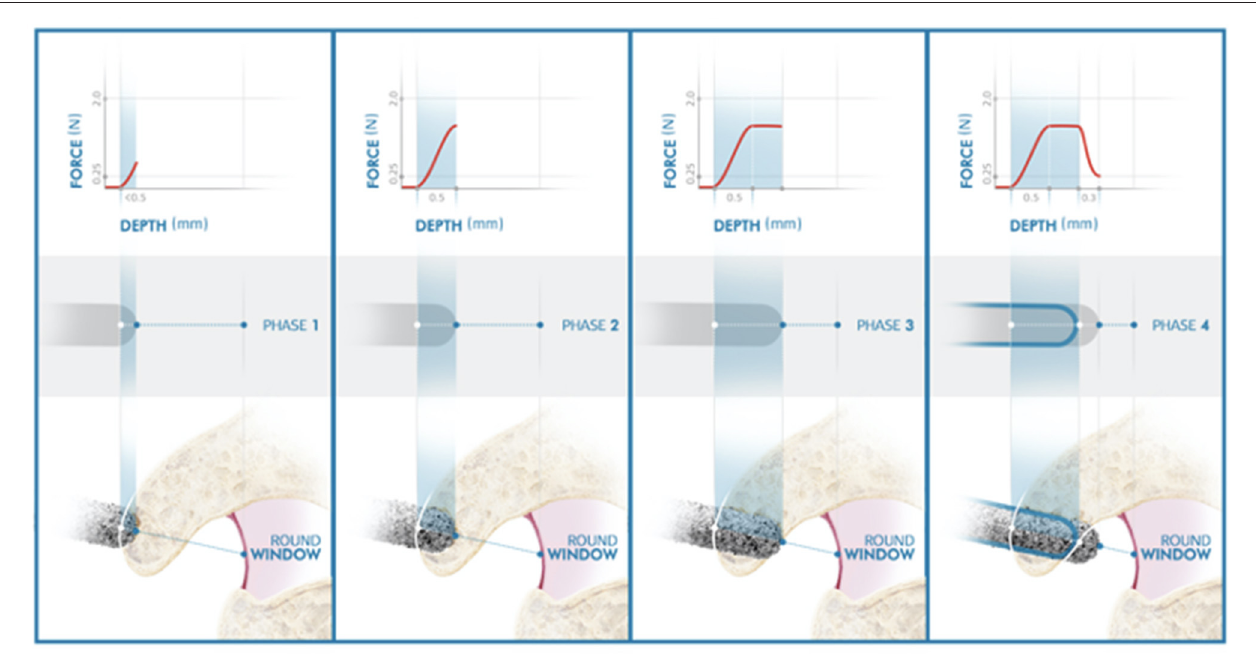
FIGURE 4 | Illustration of the inner ear access of the HEARO. The distance between point lateral wall (LW) and medial wall (MW) represents the bone thickness of the inner ear access point. The red rectangle under the graph also represents the thickness of the bony wall. The white solid line on the graph defines the target point set by the user at the preoperative planning stage. The filled blue line represents the force transients and the exact force at each specific point and is also displayed inside the burr illustration under the graph. The dashed white line represents the estimated point at which the size of 0.9mm for the opening is